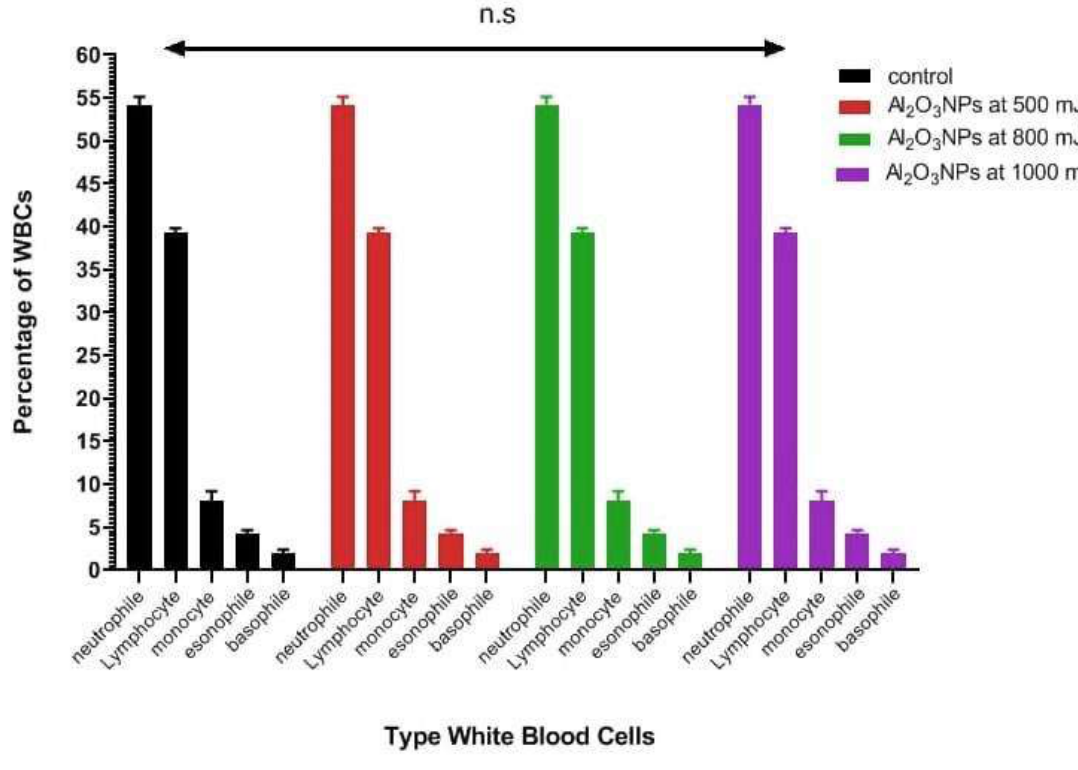
Figure 11: Total percentage of WBCs in a blood sample in the presence and absence of Al 2 O 3 NPS at different energy (500, 800, and 1000) mJ.